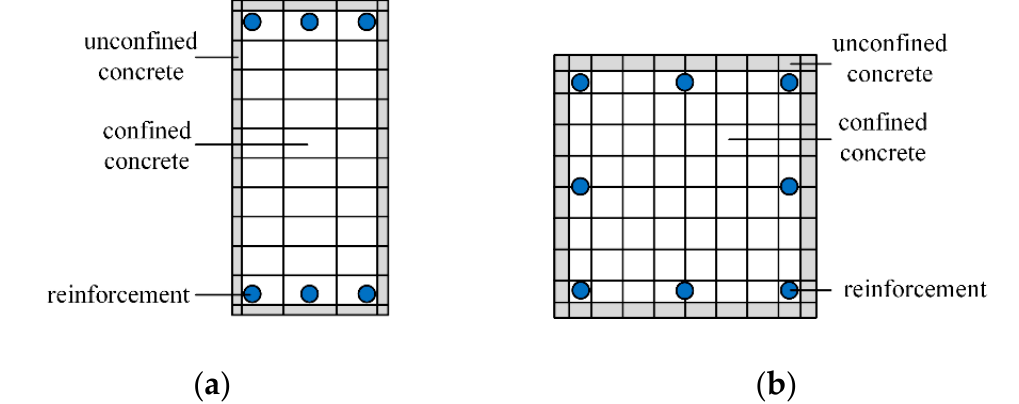
Figure 2. Fiber division of beam and column section: ( a ) beam and ( b ) column.